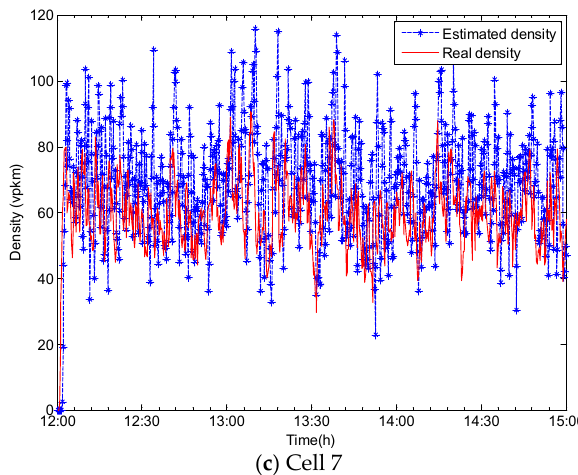
Figure 7. Comparison of simulated and estimated vehicle densities for (a) Cell 1, (b) Cell 5, and (c) Cell 7.